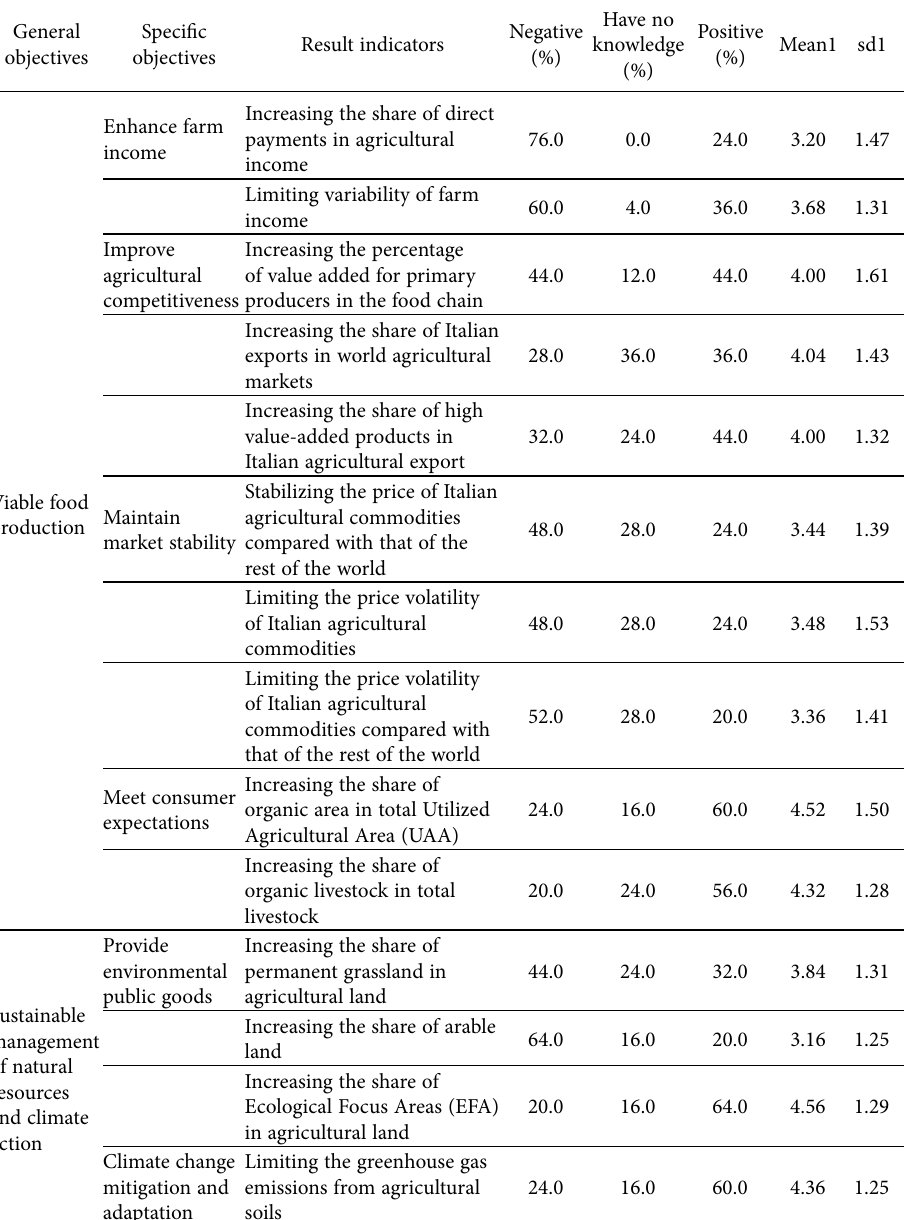
Table 5. Ex ante evaluation of Italian choices on direct payments for 2014-2020: descriptive statistics